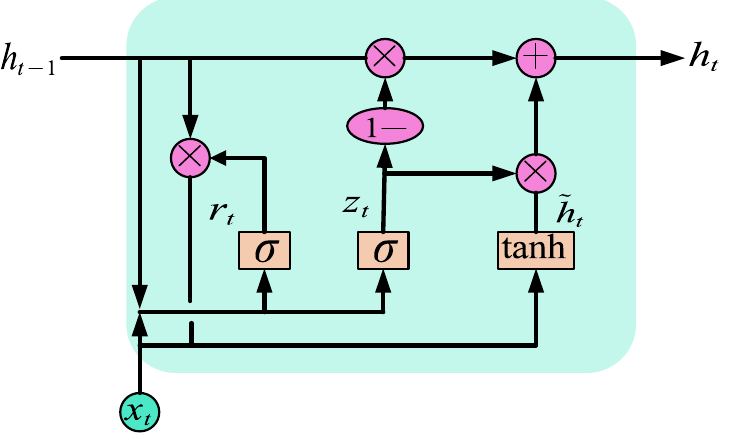
Figure 3. GRU network structure.